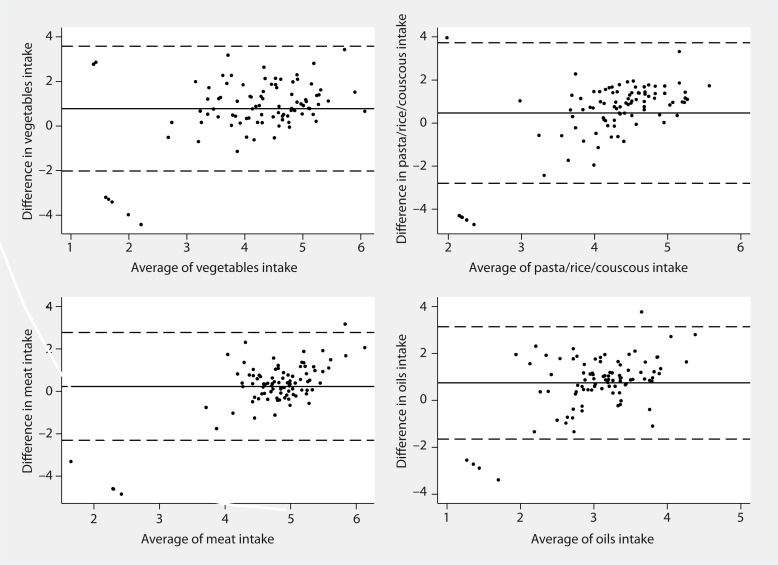
Bland–Altman plots for the comparative validity analysis of vegetables, pasta/rice/couscous, meat, and oils. The solid horizontal lines indicate the mean difference between the two methods and the broken horizontal lines indicate the lower and upper Limits of Agreement (±t91;
0.025SDs).